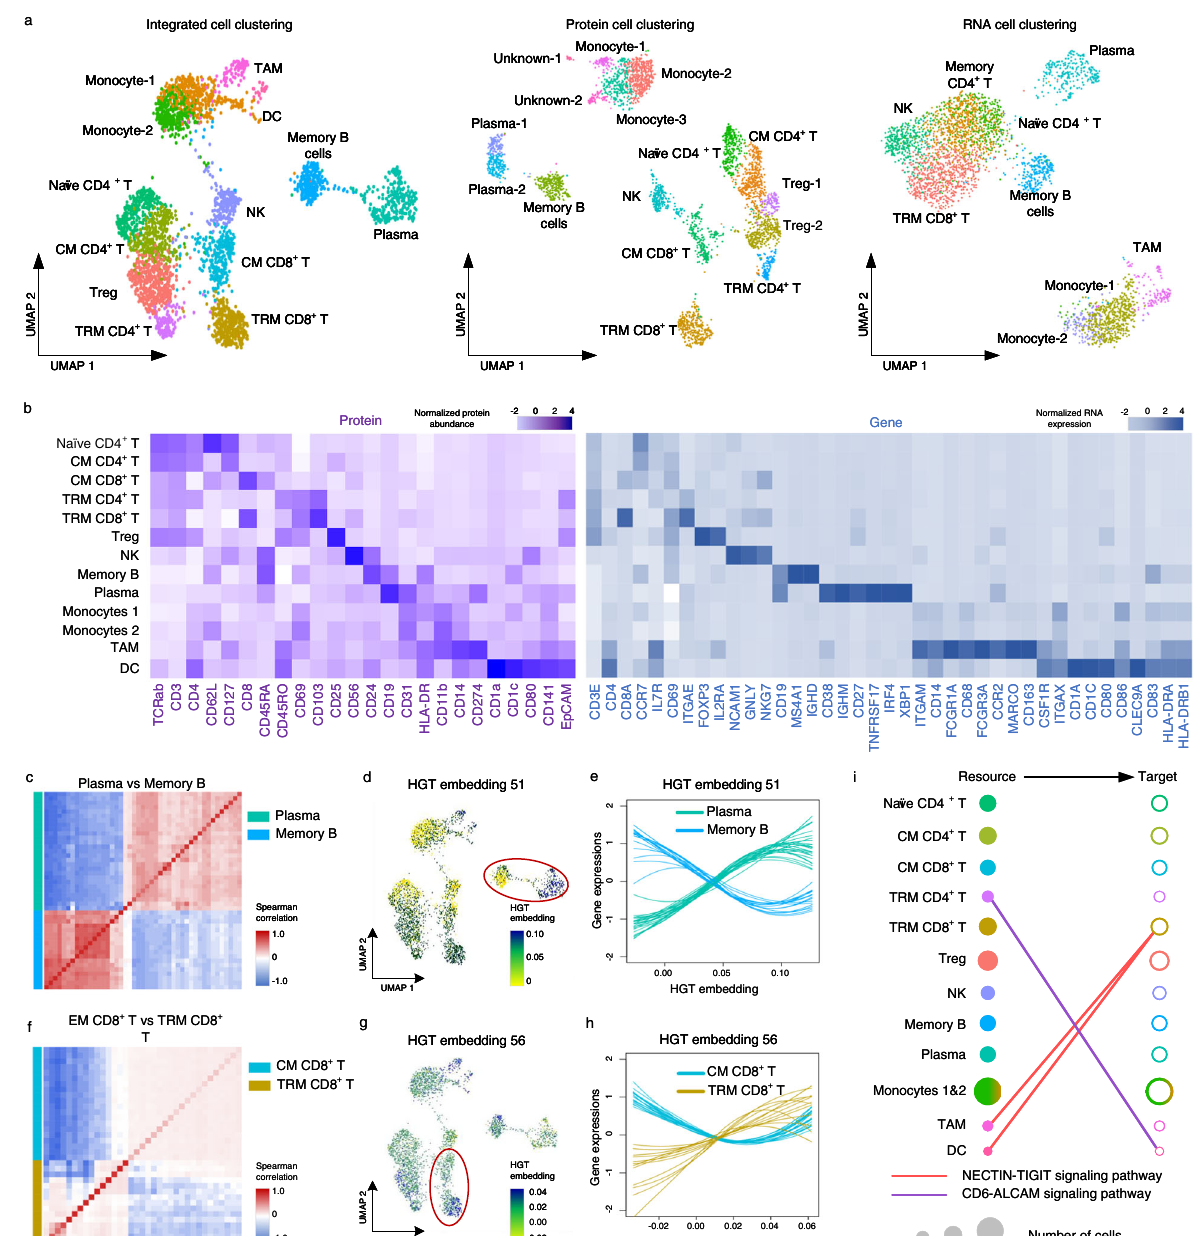
Fig.4|DeepMAPSidenti fi cationofheterogeneityinCITE-seqdataofPBMCand lung tumor leukocytes. a UMAPs for DeepMAPS cell clustering results from integratedRNAandproteindata,proteindataonly,andRNAdataonly.Cellclusters were annotated based on curated marker proteins and genes. b Heatmap of cura- ted marker proteins and genes that determine the cell clustering and